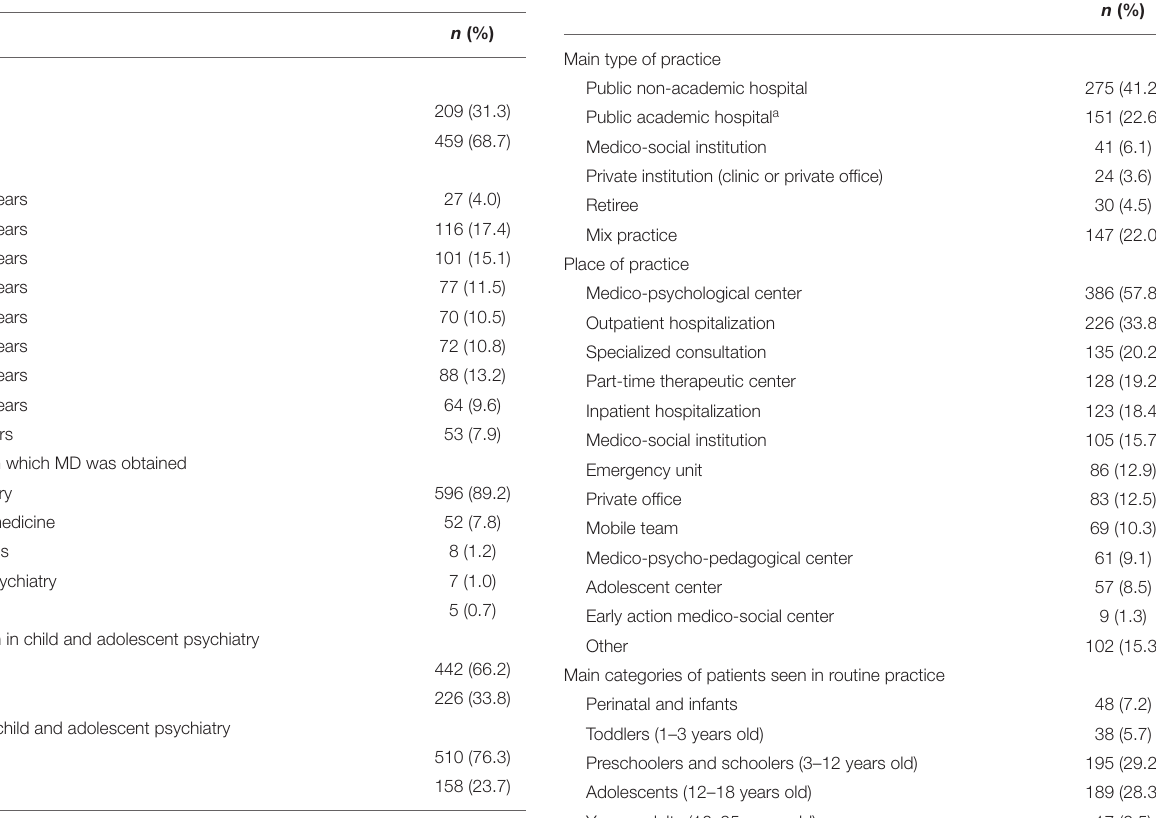
TABLE 1 | Sociodemographic and curriculum-related characteristics of respondents ( n = 668).